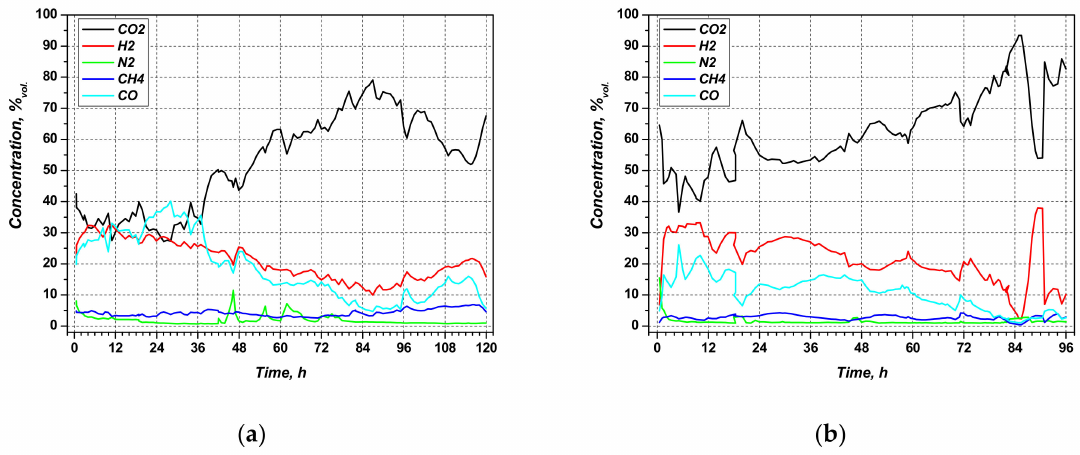
Figure 7. Changes in gas composition during the experiments: ( a ) Velenje lignite, ( b ) Oltenia lignite.